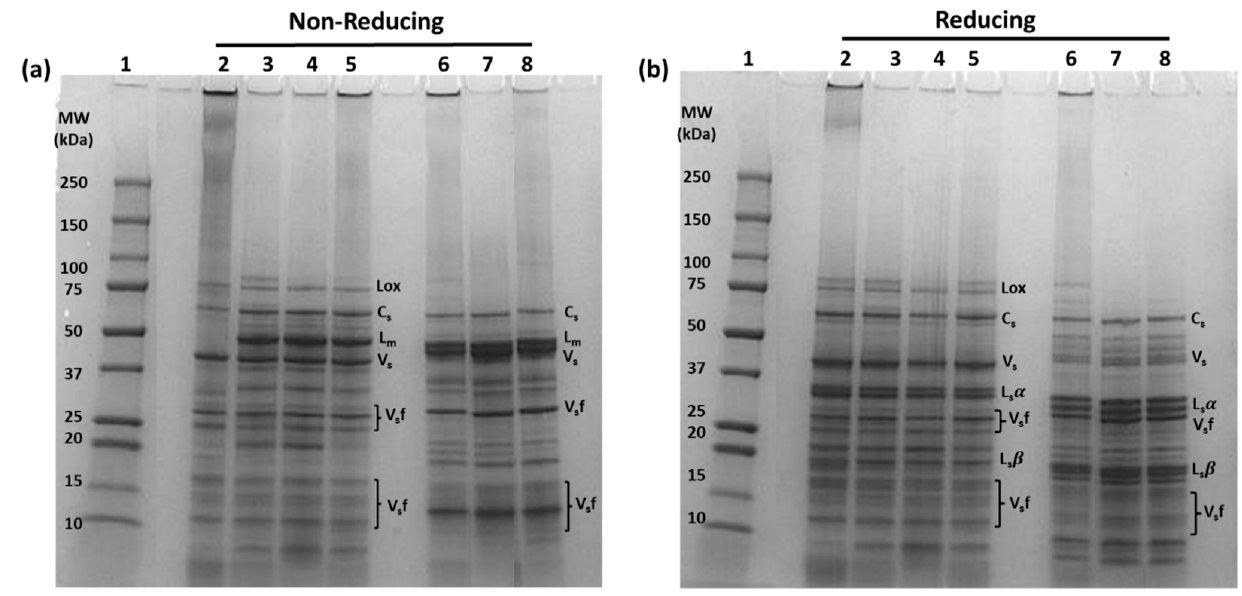
Figure 1. SDS-PAGE gel protein profile visualization of benchtop and scaled-up pea and chickpea protein isolates (PPI, SU PPI, ChPI, and SU ChPI), as well as commercial PPI, PPC, and ChPC under non-reducing ( a ) and reducing ( b ) conditions. Lane 1: Molecular weight (MW) marker; Lane 2, 3: cPPI and cPPC; Lane 4, 5: PPI and SU PPI, Lane 6: cChPC; Lane 7, 8: ChPI and SU ChPI. Lox: lipox- ygenase; C s : convicilin subunits; L m : legumin monomer; V s : vicilin subunits; L s α : legumin acidic subunits, L s β : legumin basic subunits; V s f: vicilin subunit fractions due to post-translational cleav- ages.